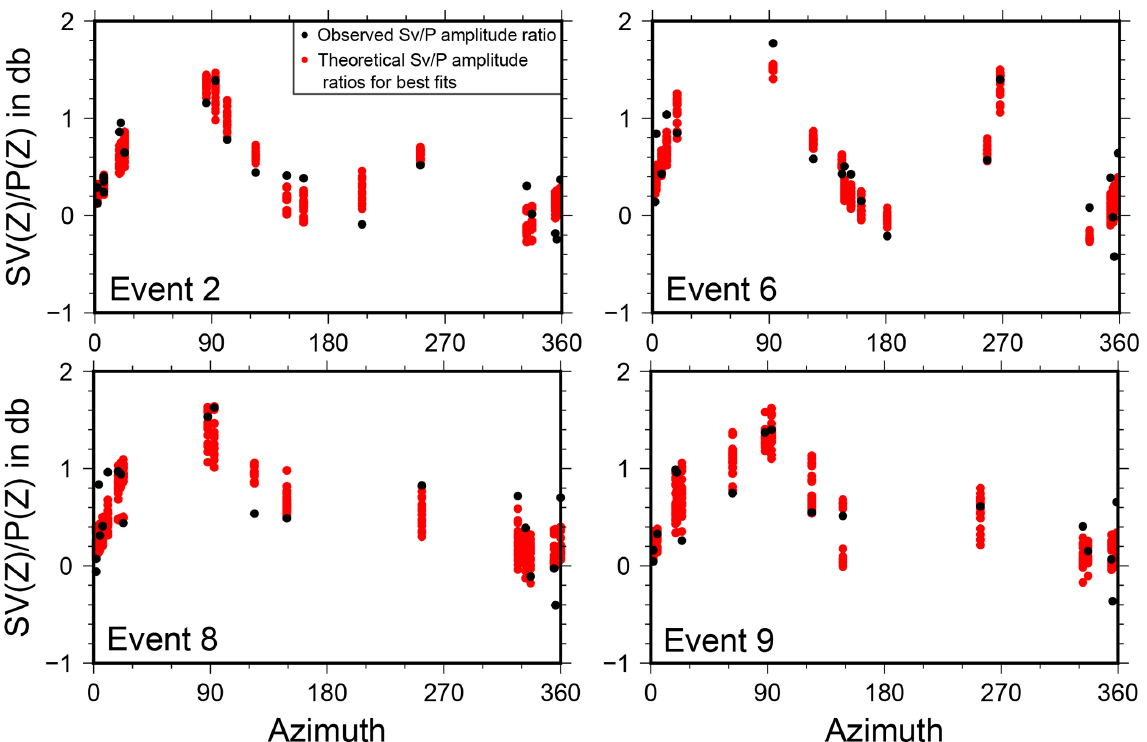
Figure A4. Amplitude ratios of Sv /P for the events 2, 6, 8 and 9. The calculated solutions for the fault plane solutions show a good fit with the observed Sv /P amplitude